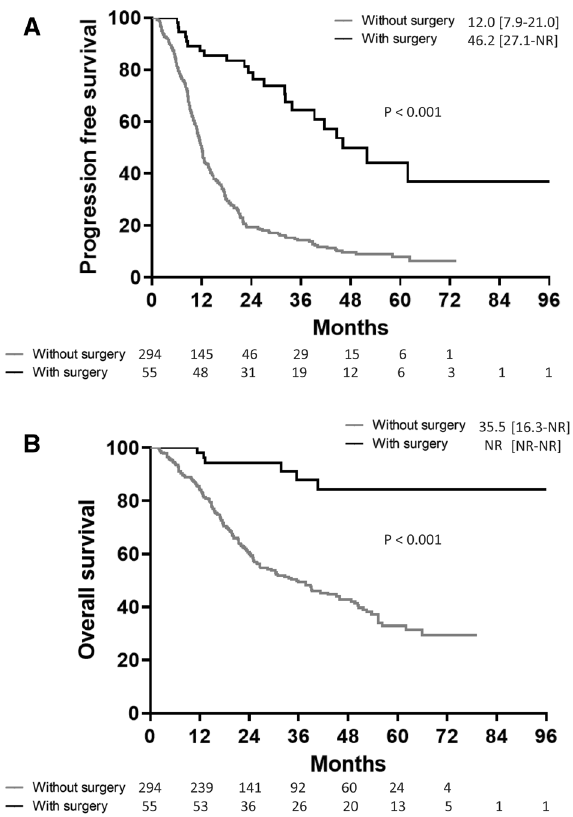
Figure 2. Progression-free survival ( A ) and overall survival ( B ) in epidermal growth factor receptor (EGFR) mutation-positive non-small cell lung cancer patients with and without primary tumor